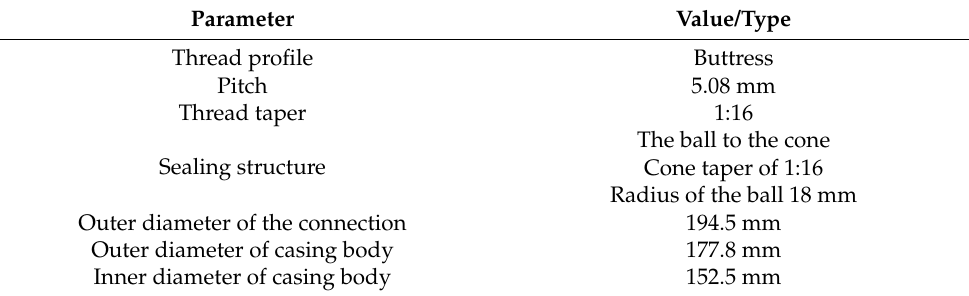
Table 2. Geometric parameters of casing connection.